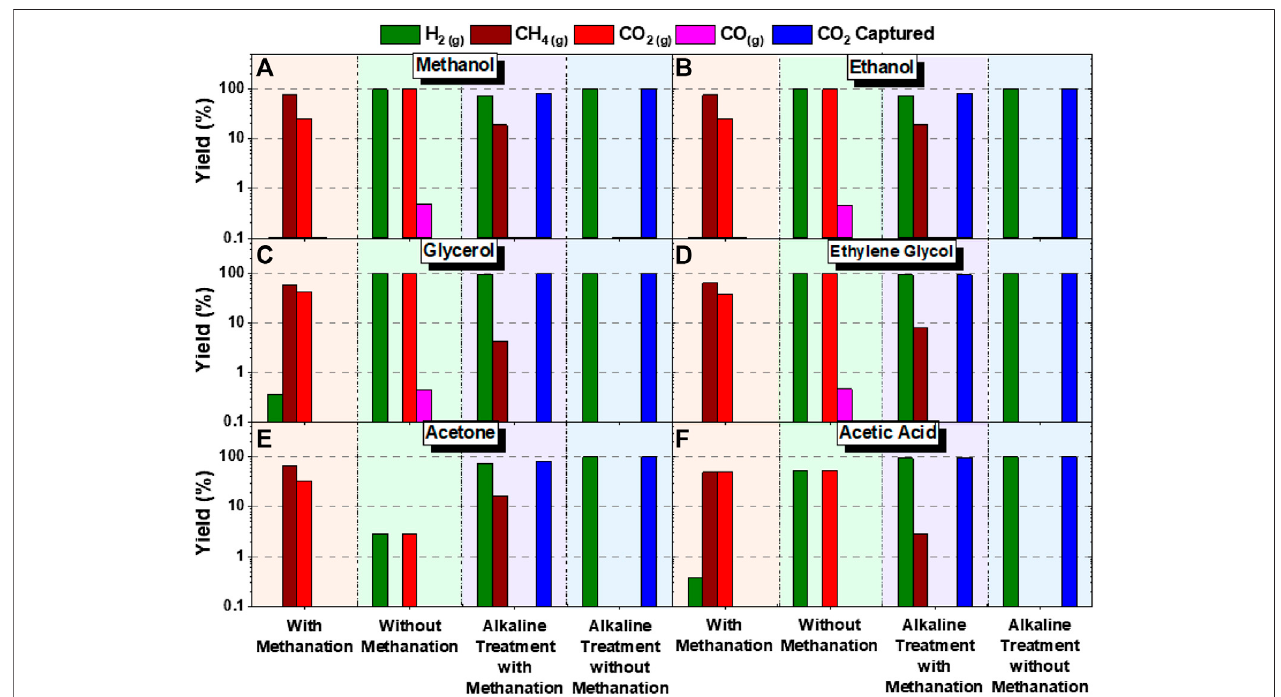
FIGURE 15 | Comparison of theoretical product yields with 20 wt% of (A) methanol, (B) ethanol, (C) glycerol, (D) ethylene glycol, (E) acetone, (F) acetic acid. Thermodynamic product yield was computed for cases with methanation, catalytic effect (without methanation reactions), alkaline treatment with methanation, and alkaline treatment with catalytic effect (without methanation reactions). These calculations are performed with temperatures of 227 ° C and pressures of 50